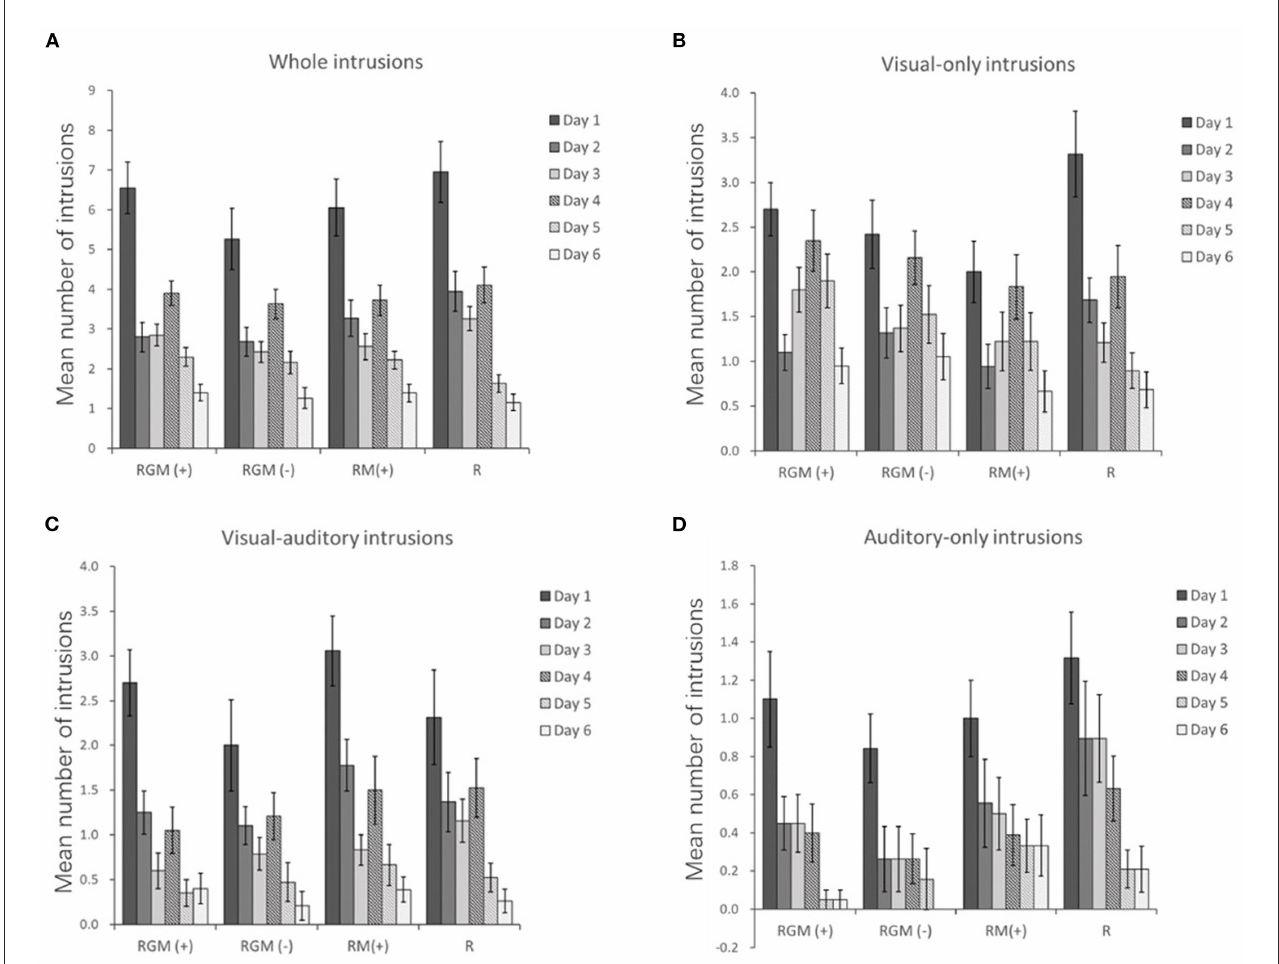
FIGURE3 Trajectory of mean number of whole (A) , visual-only (B) , visual-auditory (C) , and auditory-only (D) intrusions. Error bars depict SEMs.